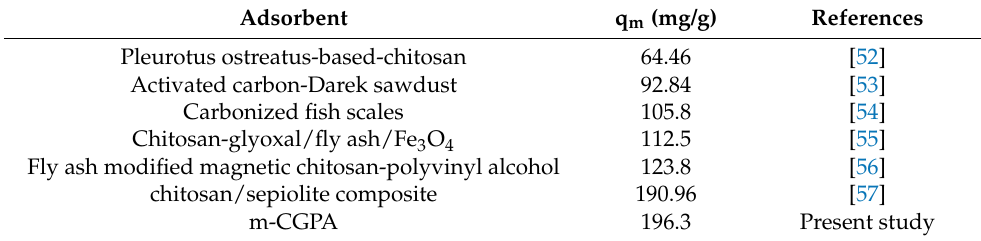
Table 3. Adsorption capacities of different kinds of adsorbents toward RO 16 dye adsorption.